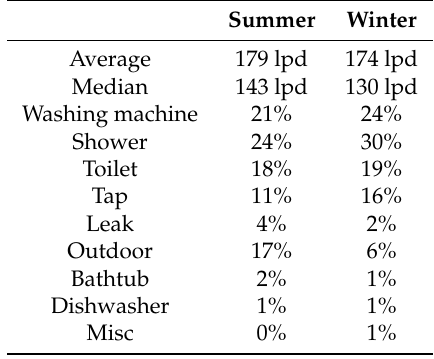
Table 2. Water usage profile in Auckland, New Zealand.